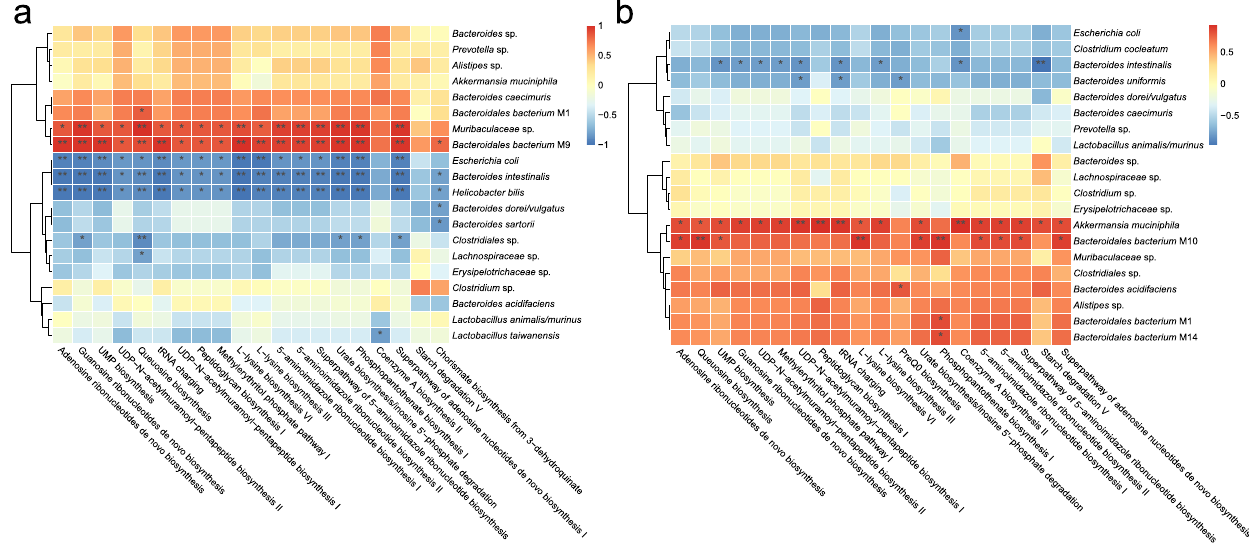
Fig. 6 Postbiotics and probiotics caused divergent changes in the intragroup associations between fecal microbes and metabolic pathways. Spearman ’ s correlation heatmap of top 20 bacterial species and metabolic pathways in the fecal microbiota of Postbiotic group ( a ) and Probiotic group ( b ) at the end of the animal trial. The color intensity is proportional to the strength of Spearman ’ s correlation. * P < 0.05; ** P <